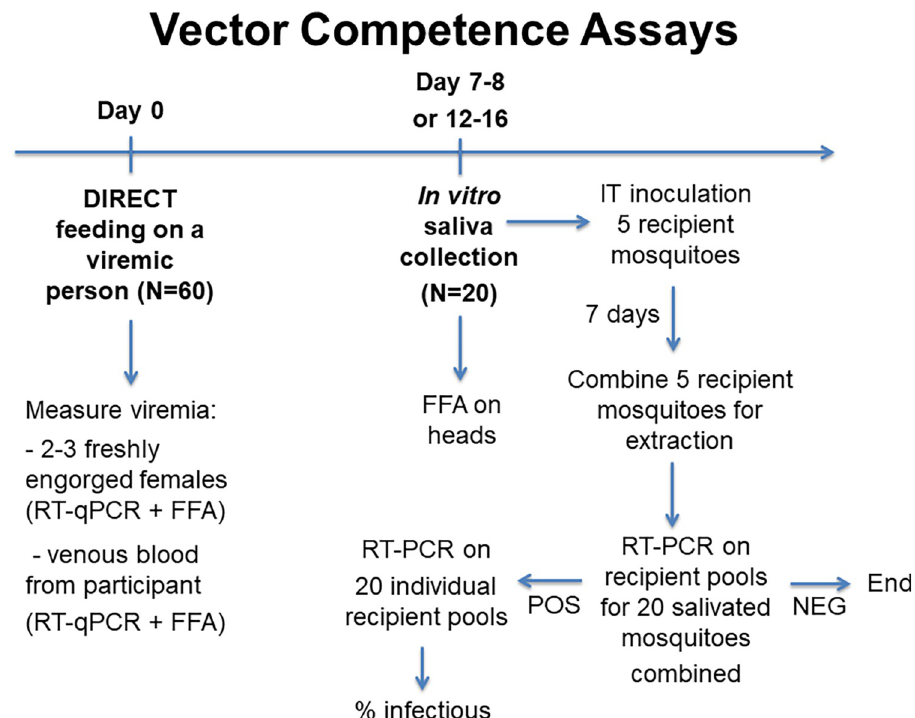
Fig 3. Workflow for mosquito feeding procedures carried out on DENV/ZIKV infected study participants. FFA = Fluorescent Focus Assay, RT-PCR = Reverse Transcriptase Polymerase Chain